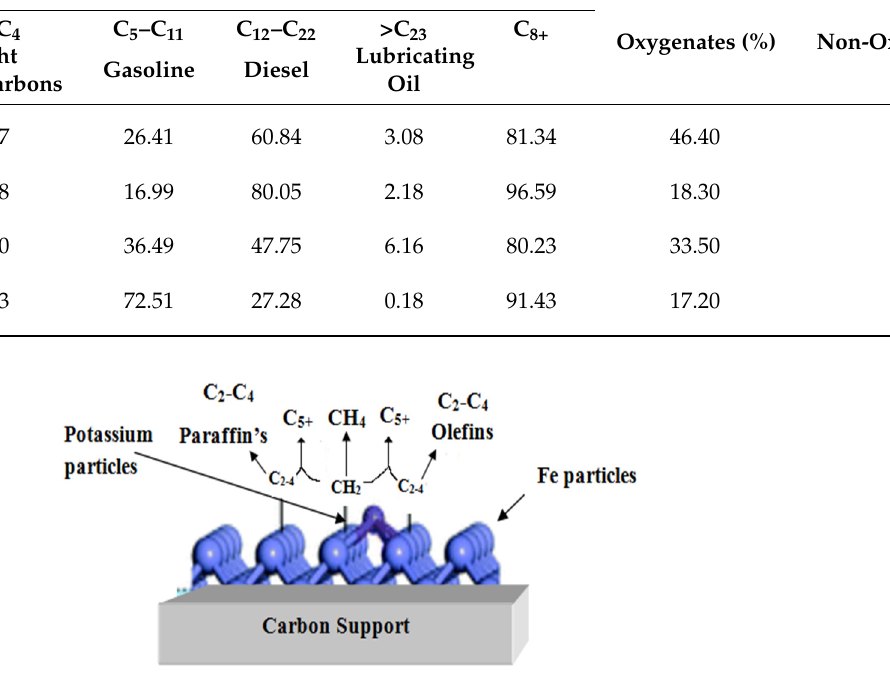
Table 3 . Distribution of carbon chain with oxygenates and non-oxygenates .